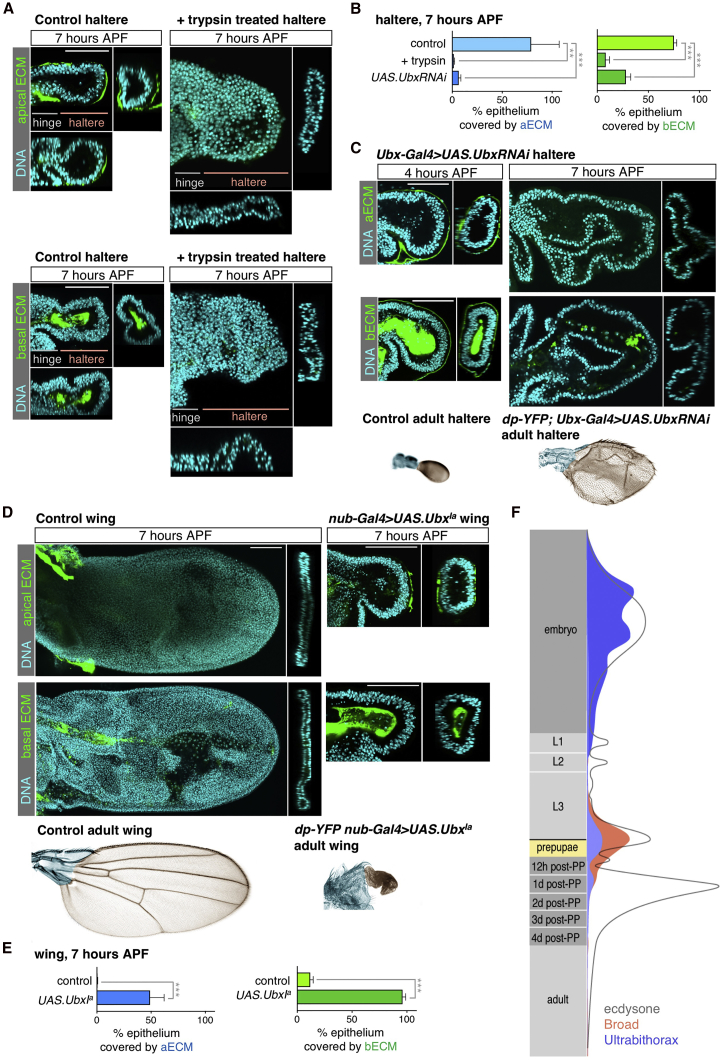
Ubx Blocks Matrix Degradation to Prevent Elongation of the Haltere(A) Cross-sections of the developing haltere at 7 hr APF. Degradation of Dp-YFP (top) and Vkg-GFP (bottom) during haltere development by addition of trypsin protease for 15 min results in the elongation and flattening of the haltere, coupled with columnar-to-cuboidal cell shape change. The result is a “winglet”-like structure that is much smaller than the wing itself at this stage due to the fact that the haltere comprises fewer cells than the wing throughout its early growth phase. Haltere and hinge epithelia are highlighted. Note that number of nuclei in the cross-sections is similar in the control and the treated haltere (approximately 40); the apparent increase in cell number in the treated haltere is an effect of the tissue being flattened and expanded. Scale bar, 50 μm.(B) Quantification of the percentage of epithelium covered with apical Dp-YFP and basal Vkg-GFP in 7 hr APF control, trypsin treated, or expressing UbxRNAi (Ubx-Gal4>UAS.UbxRNAi) halteres. Average and SD are presented; n > 4. Statistically significant differences are indicated (∗∗p < 0.005, ∗∗∗p < 0.001).(C) Cross-sections of the entire developing haltere at 4 and 7 hr APF in dp-YFP/+; Ubx-Gal4>UAS.UbxRNAi, and in vkg-YFP/+; Ubx-Gal4>UAS.UbxRNAi halteres (top). Loss of Ubx resulted in degradation of both apical and basal ECM and consequent expansion and extension of the haltere. Adult halteres from control and animals expressing RNAi against Ubx. Depletion of Ubx transform the haltere into a “winglet” (bottom). Scale bars, 50 μm.(D) Cross-sections of 7 hr APF control and wings (top) ectopically overexpressing gain-of-function Ubx allele (nub-Gal4>UAS.UbxIa), which has been reported to cause transformation into a haltere-like structure, but whose mechanism of action has remained unclear (Pavlopoulos and Akam, 2011). Ubx-expressing wings have not expanded and elongated at 7 hr APF, and are still covered by apical dp-YFP or Vkg-GFP, even though the peripodial membrane has been released. Bottom: adult wings from control and from animals overexpressing the gain-of-function Ubx allele. Scale bars, 50 μm.(E) Quantification of the percentage of epithelium covered with apical Dp-YFP and basal Vkg-GFP in 7 hr APF control and overexpressing UbxIa wings. Average and SD are presented; n > 4. Statistically significant differences are indicated (∗∗∗p < 0.001).(F) Schematic graph of the timing of the homeobox gene Ubx mRNA induction just following the peak of ecdysone synthesis at pupariation (adapted from www.flybase.org, modEnCODE Development RNA-Seq database [Graveley et al., 2011, modENCODE Consortium et al., 2010]).See also Figure S6.